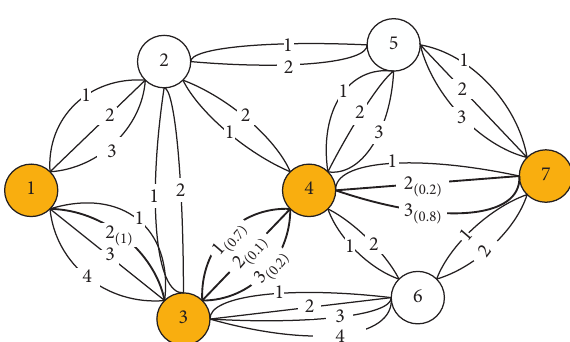
Figure 5: Optimal route scheme for example I.